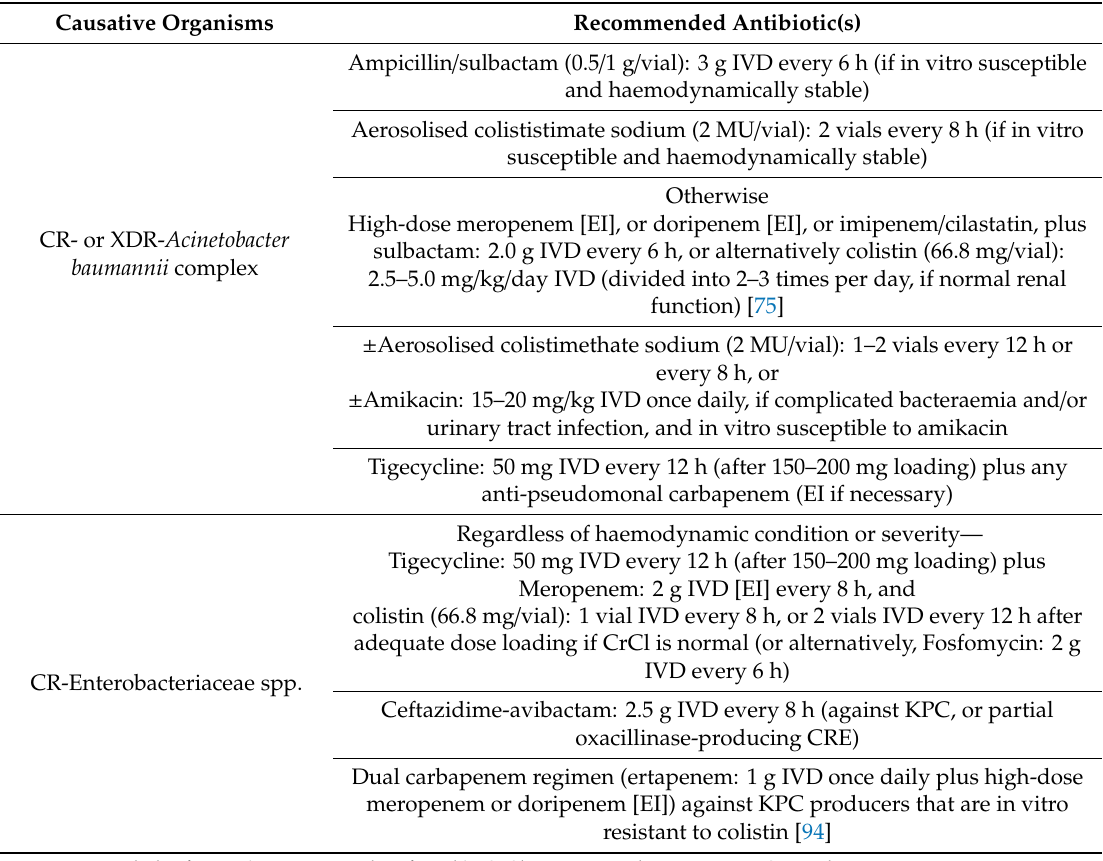
Table 3. The recommended antibiotic regimens and dosage (if creatinine clearance rates > 50 mL / min) for patients with hospital-acquired or ventilator-associated pneumonia related to extensively drug-resistant Acinetobacter baumannii complex species and carbapenem-resistant Enterobacteriaceae. Causative